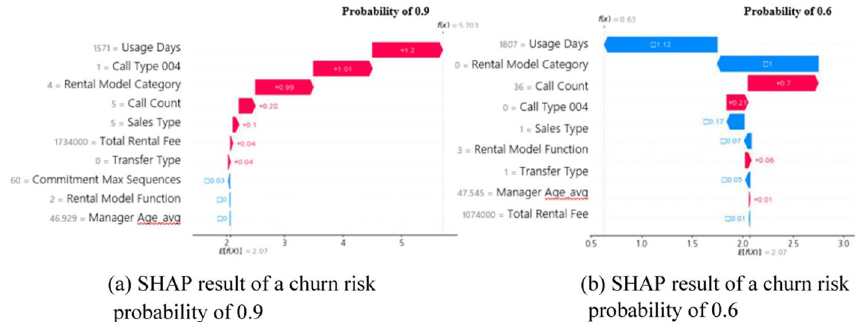
Fig. 17 SHAP-based analysis results. a SHAP result of a churn risk probability of 0.9 ( b ) SHAP result of a churn risk probability of